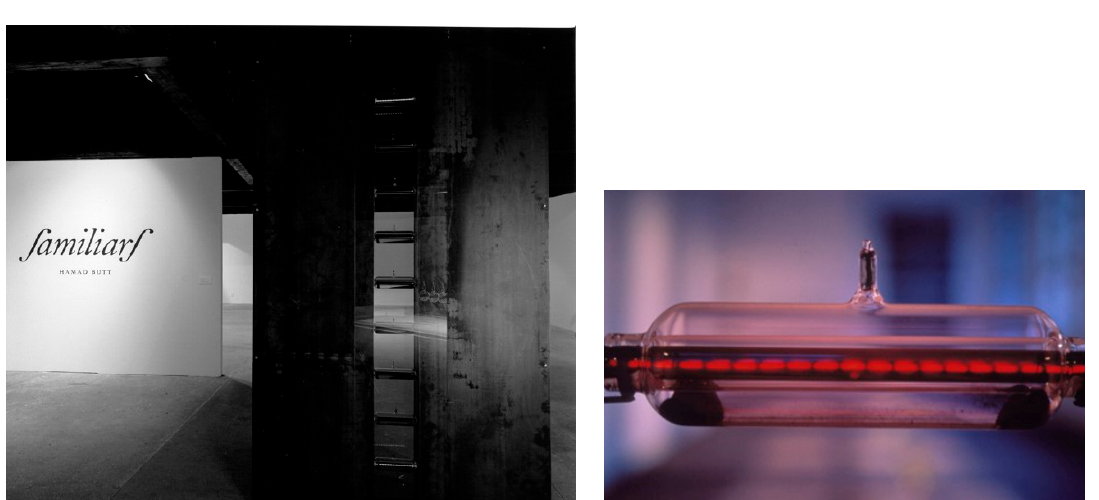
Figure 15. Butt. 1992. Substance Sublimation Unit .